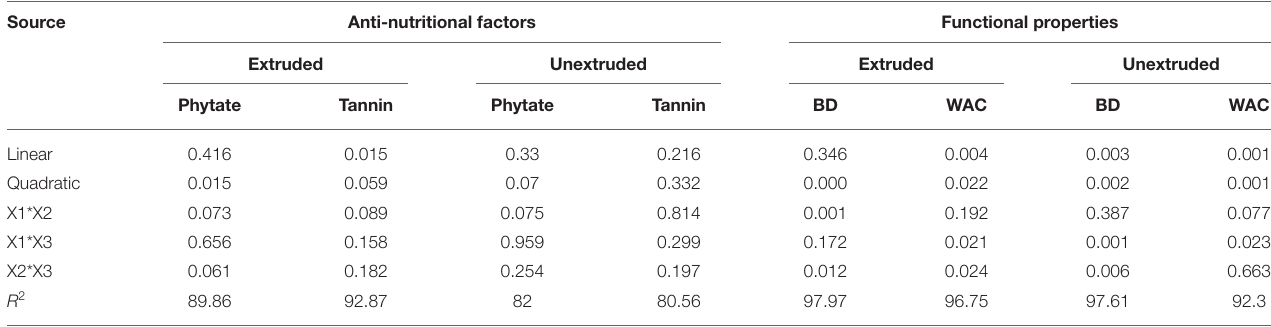
TABLE 2 | Analysis of variance (ANOVA) for anti-nutritional factors content and functional properties.